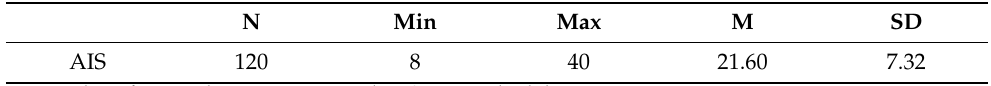
Table 6. General acceptance-of-illness index.